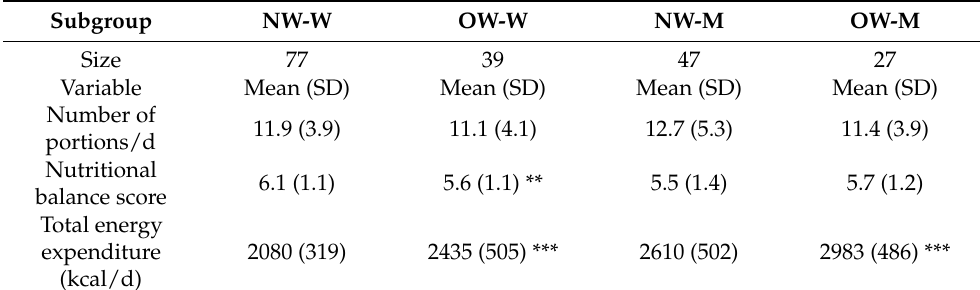
Table 2. Effect of BMI status on behavioral data in men and women. (Mean values ± standard deviations, all the subjects). Subgroup NW-W OW-W NW-M OW-M Size 77 39